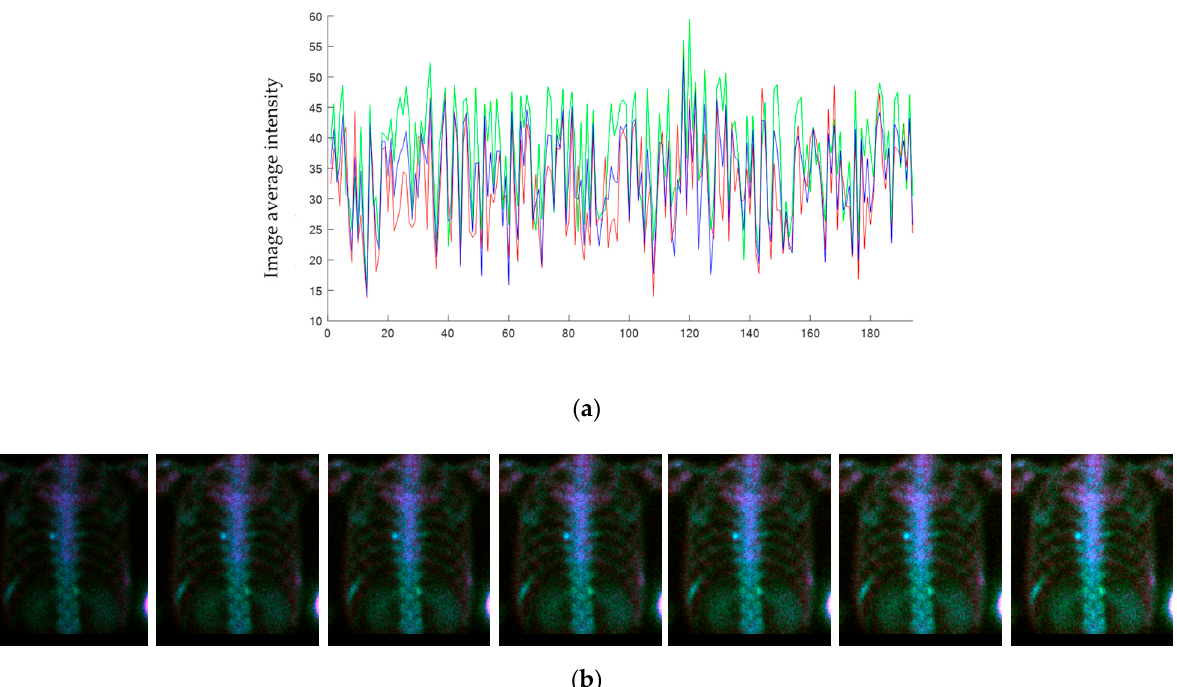
Figure 4. ( a ) The average intensity of each chest image. The color denotes the corresponding channel in the color image, as shown in Figure 2c. The abscissa shows the case numbers; the ordinate shows the average image intensities. ( b ) The 7 different intensities were augmented as an illustration. (Case number 07).